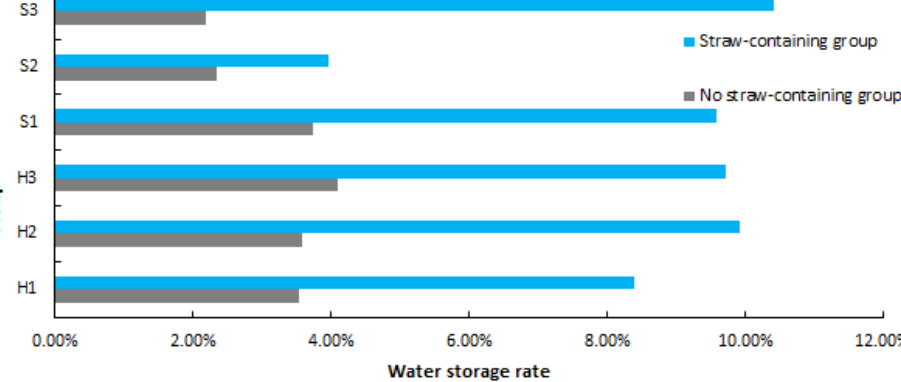
Figure 7. Comparison of water storage rate of specimens after 72 h immersion.